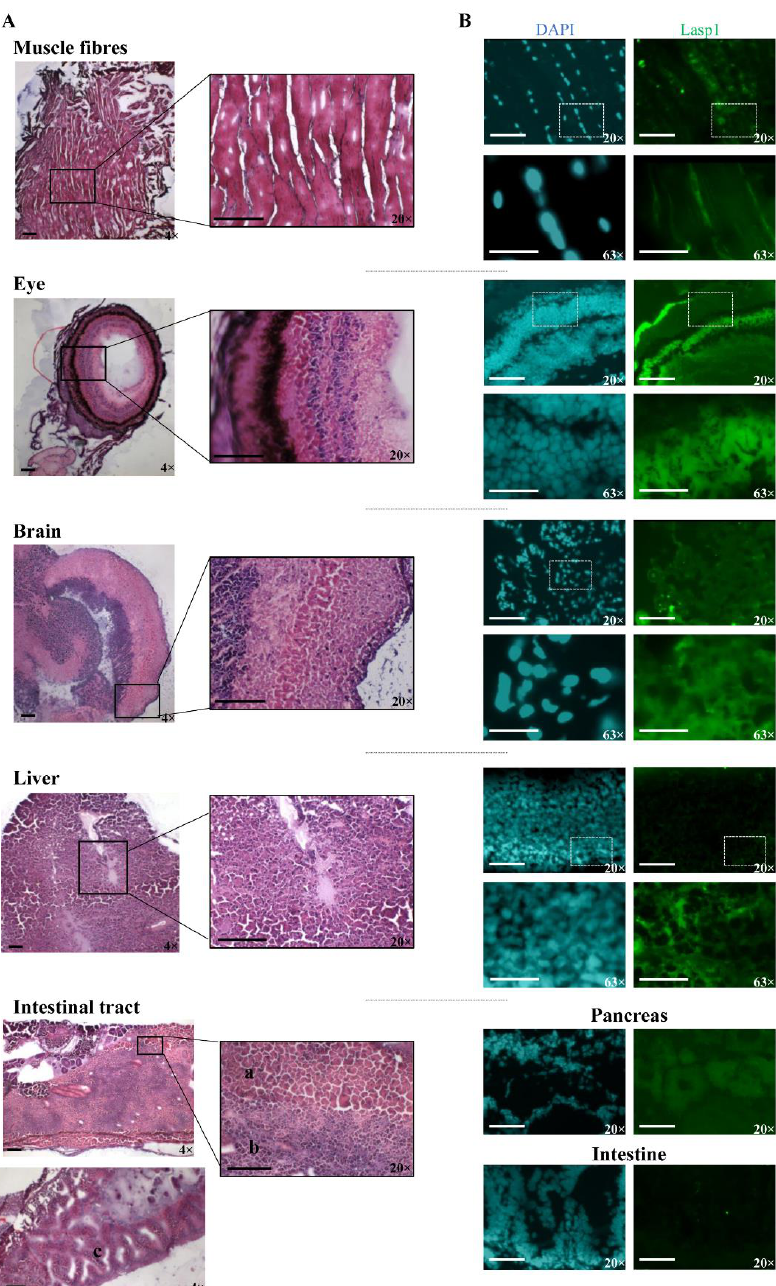
Figure 2. Detection of Lasp1 protein expression in various organs and tissues of zebrafish, including the muscle, the eye, the brain, the liver and the gastrointestinal tract. ( A ) Histological analysis by hematoxylin and eosin staining of muscle fiber, eye, brain, liver and intestinal tract tissue sections. Pancreas ( a ), liver ( b ), and intestine ( c ) samples are indicated. Magnification: 4× and 20×. ( B ) Immunofluorescence detection of Lasp1 (green) in the selected tissue sections by immunohistochemistry with Alexa photosensitive antibodies. Magnification: 20× and 63× (blue: DAPI; green: FITC). Scale bars are placed at the lower left corner of each image and correspond to 100 µm for 4× and 20× magnification and to 30 µm for 63× magnification.